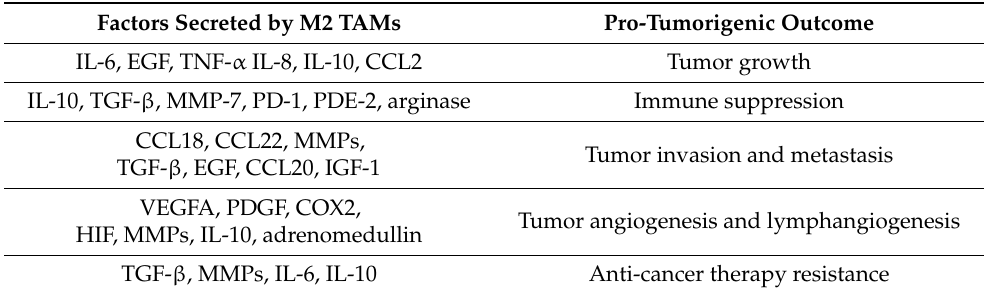
Table 3. Soluble factors secreted by M2-polarized TAMs, influencing various pro-tumor outcomes. Factors Secreted by M2 TAMs Pro-Tumorigenic